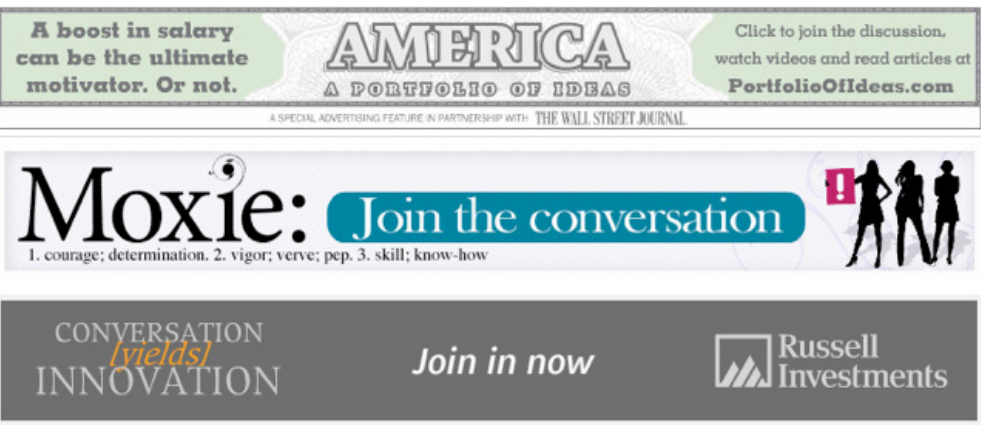
Figure 1: Proliferating Invitations to Join Public Dialogues from Companies Seeking to Capitalize on “The Conversation